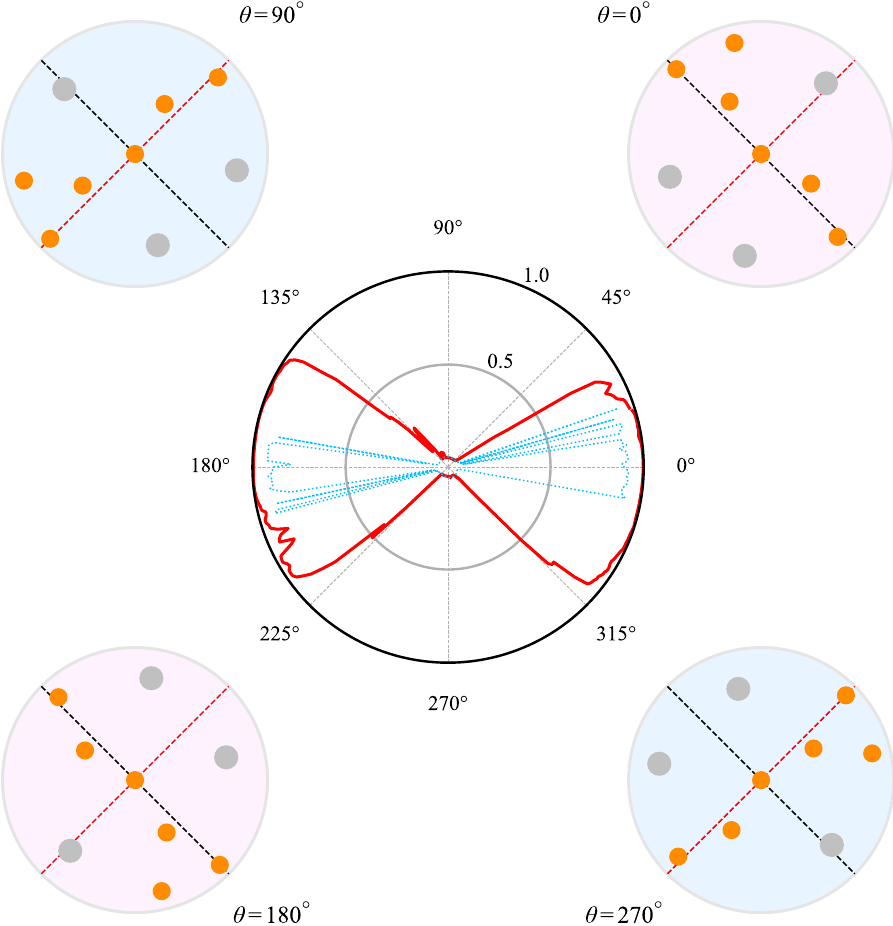
Fig. 4 The orientation dependence of CNN-predicted plastic susceptibility for a 2D local con fi guration. This susceptibility is characterized here by the magnitude of class probability (red solid curve), varying in the range of 0 – 1 (black circle in the center), depending on the rotation angle ( θ ) of the local con fi guration relative to the loading orientation (four scenarios during the counter-clockwise rotation at representative angles are displayed). The red and black dashed lines in each snapshot represent the elongation and contraction directions of the global loading, respectively. The blue dotted line in the polar plot represents D 2 min of the local con fi guration at different θ